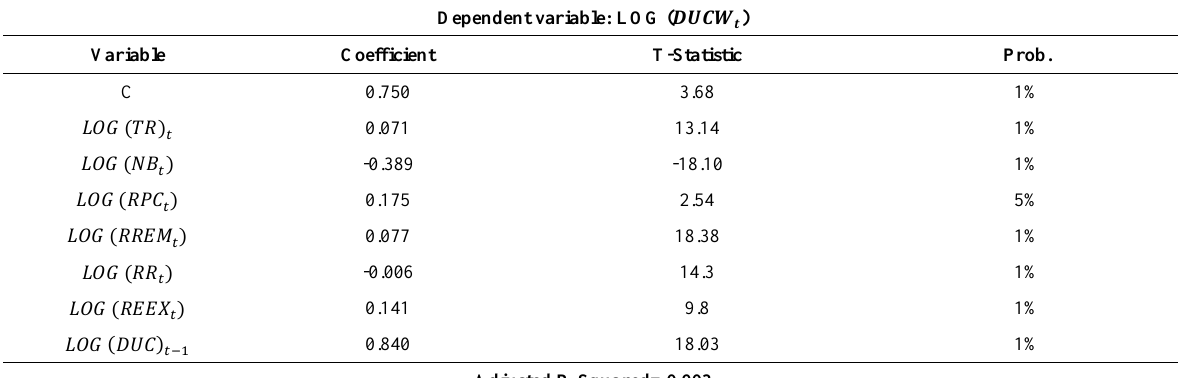
Table 3. The results of estimating the demand equation for the circulation currency in the presence of tax.